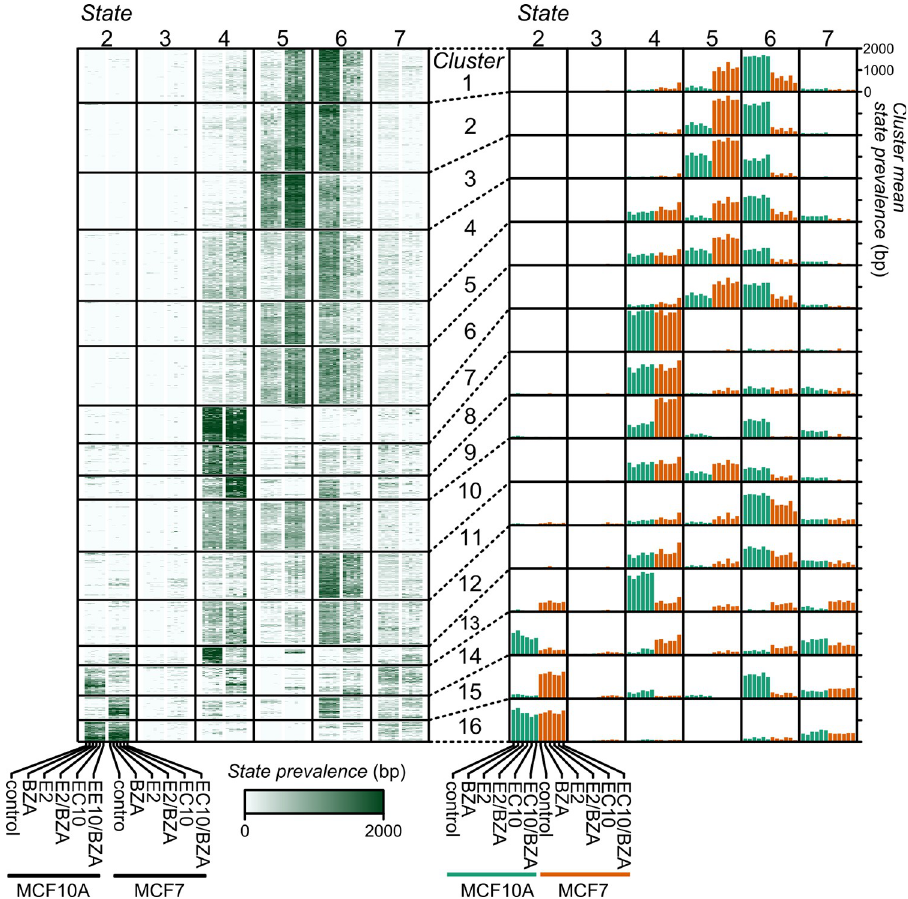
Fig 3. Chromatin state dynamics near RefSeq gene Transcription Start Sites (TSS) in MCF10A and MCF7 cells treated with bazedoxifene. The number of base pairs assigned to each state is within a 2kb window centered on 18,614 TSSs clustered and presented in heatmaps (left) or aggregated barplots (right). State 1 is omitted due to its extreme rarity in order to improve clarity. Minor columns represent the prevalence of the state in each cell line and treatment combination as indicated at the bottom, repeating in each major column (left panel). For the right panel, the clusters are summarized by mean value and the columns are arranged as in the left panel. Chromatin states: 2 –repression; 3 – mixed signal; 4 –low signal; 5 –active; 6 –poised; 7 –low